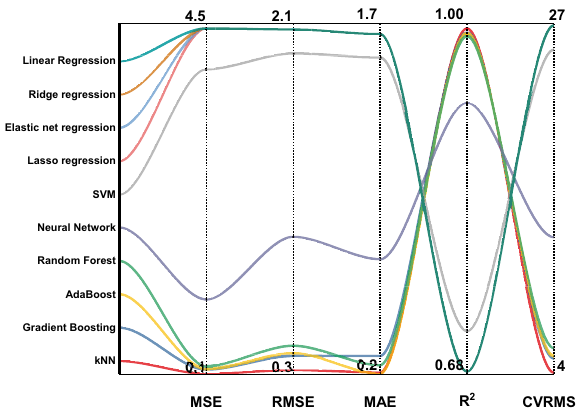
Figure 5. Output results of performed regression algorithms of Linear, Ridge, Lasso, Elastic Net, Polynomial, Support vector machine (SVM) Regresso, Gradient Boosting, AdaBoost, and Random Forest Regressor.